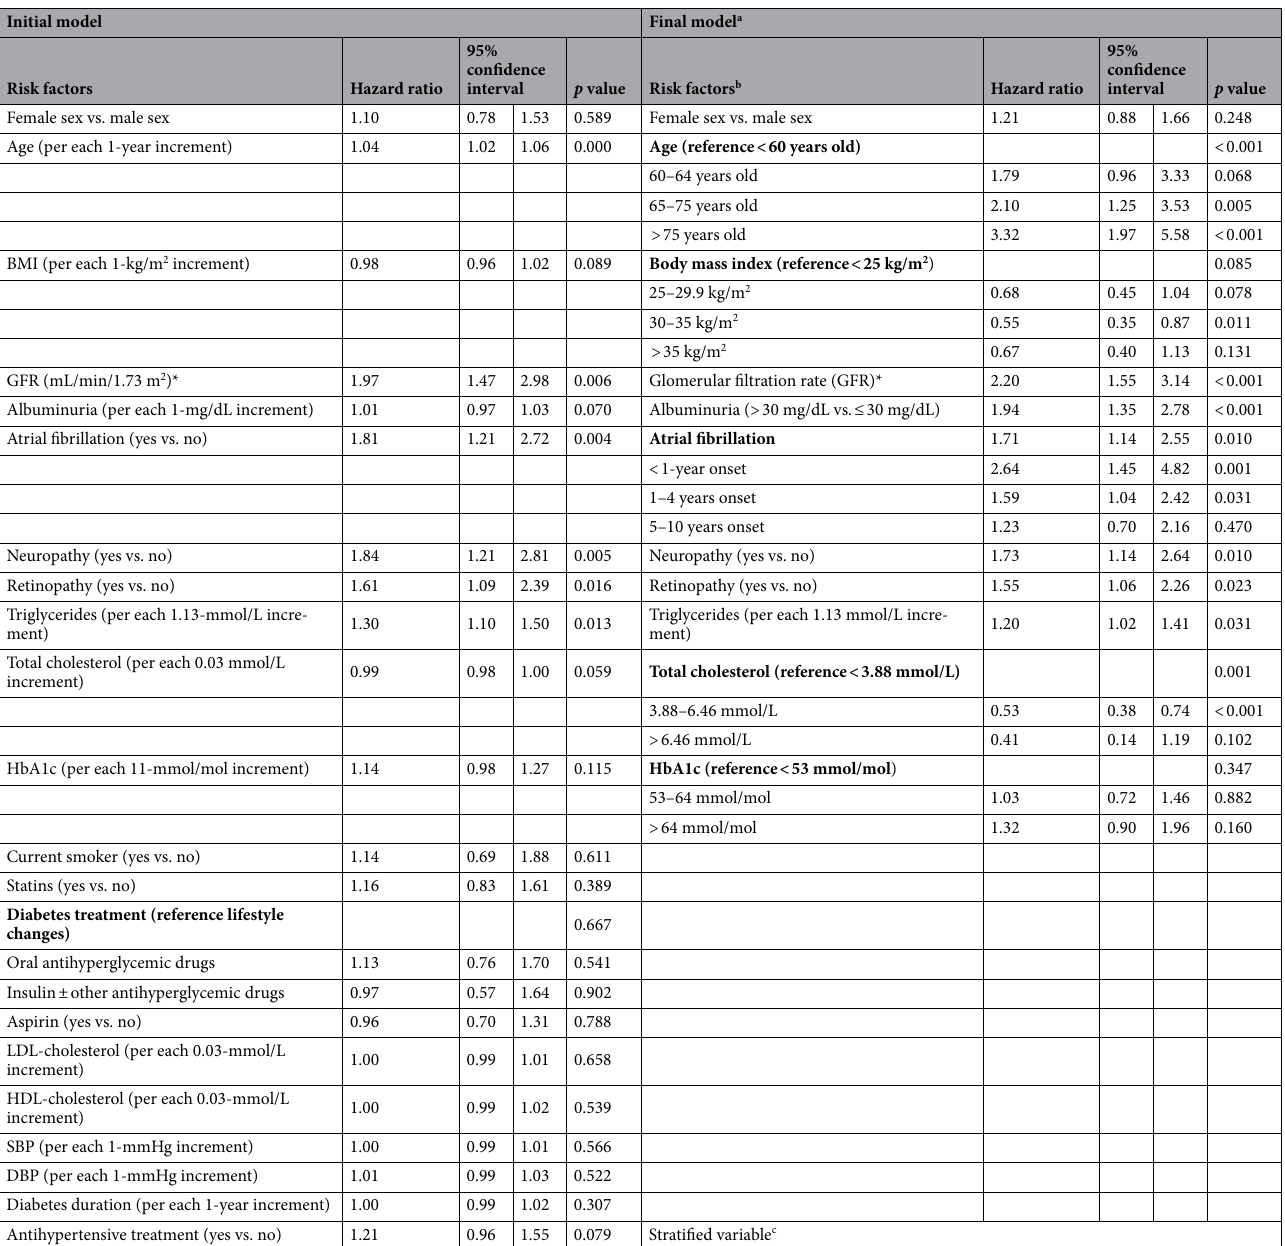
Table 3. Multivariable analysis of factors associated with incident first stroke/transient ischemic in the MADIABETES cohort. BMI Body mass index, HbA1c Glycated hemoglobin, HDL-cholesterol High-density lipoprotein cholesterol, LDL-cholesterol Low-density lipoprotein, SBP Systolic blood pressure, DBP Diastolic blood pressure. *GFR: Glomerular filtration rate per each 15 mL/min/1.73 m 2 decrease. a Backward elimination (Supplementary Fig. S1). b BMI, albuminuria, and cholesterol were kept as continuous variables for the descriptive analyses and the initial model of Cox regression. Subsequently, the variables were categorized, given the non-linear effect de these variables on outcomes (Supplementary Figs. S2 and S3). Age and HbA1c were categorized according to clinical relevance. c The inclusion as an independent variable produced inconsistent results given that the vast majority of the cardiovascular events were concentrated in the category of patients taking antihypertensive drugs. We repeated the analysis stratifying by this variable that allows taking it into account in the adjustment and solving this